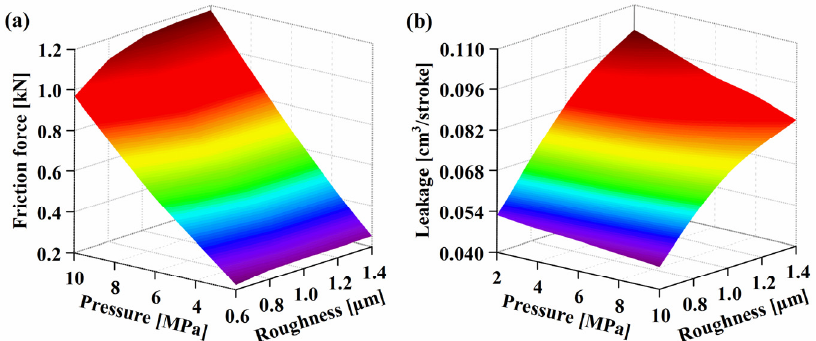
Figure 10. Variation of friction force and fluid leakage with sealed pressure and surface roughness: ( a ) friction force, ( b ) fluid leakage.